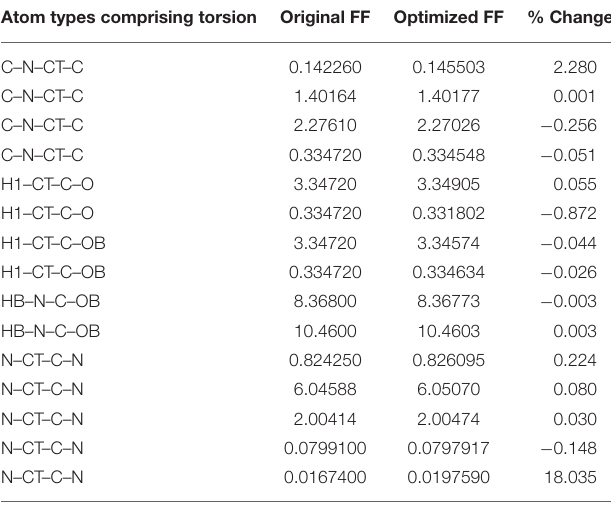
TABLE 1 | Original and optimized torsion angle parameters for RS-peptide. Atom types comprising torsion Original FF Optimized FF %